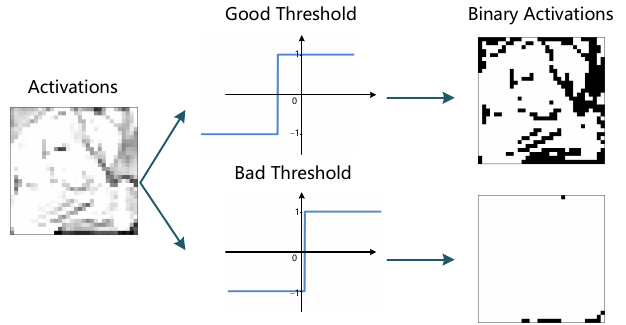
Figure 2. The visualization of the binary activations generated by different sign functions. The sign function above with a negative threshold generates the informative binary activation which retains the information of the original input. The sign function below with a small positive threshold generates the meaningless binary activation which causes huge information